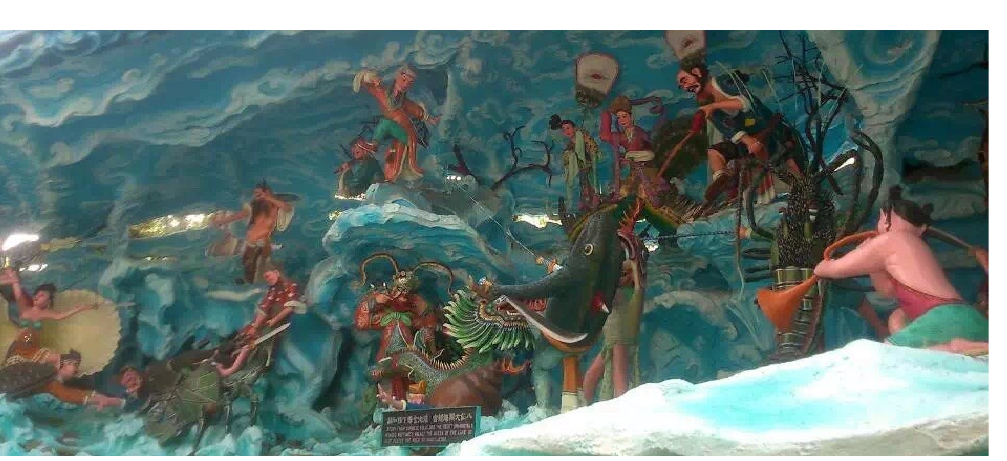
Figure 8. Partial view of the group sculptures of the Eight Immortals in Haw Par Villa.